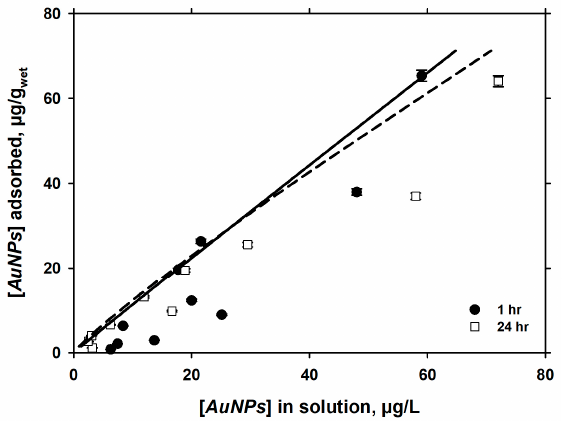
Figure 9. Adsorption of AuNPs on EOMI surfaces after 1 and 24 h of reaction at pH = 7.2 ± 0.2 in 0.01 M NaCl. The solid lines represent a Freundlich isotherm fit to the data. The error bars are within the symbol size unless shown. They correspond to standard deviation of duplicates.